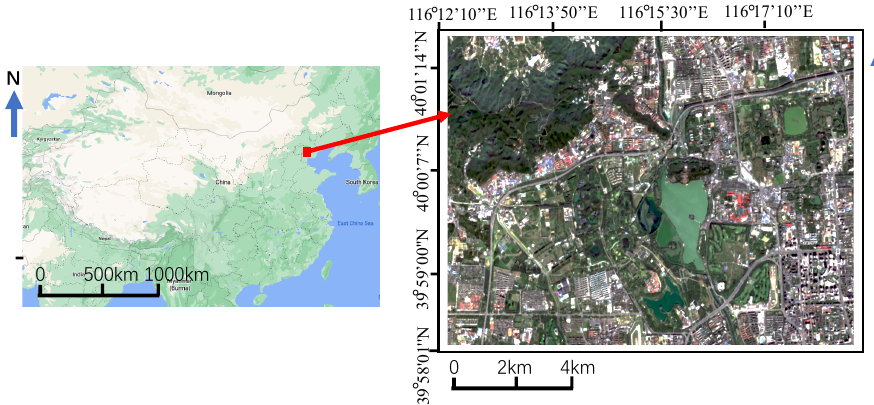
Figure 1. The study area in Beijing, China and its zoom-in satellite image (false-color RGB). Table 2. A summary of the study area and satellite image. Location No. of Bands Image Size Cloud Cover